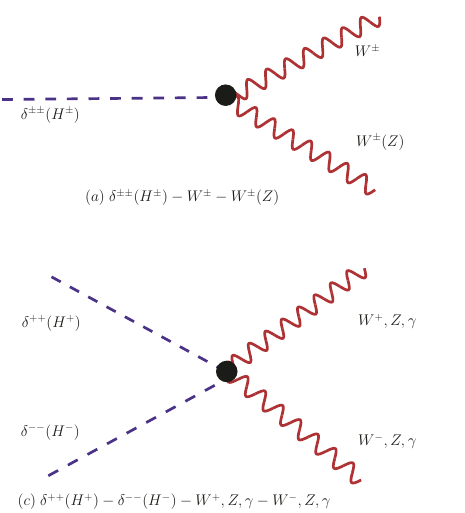
- l (cid:7) vertices. a b